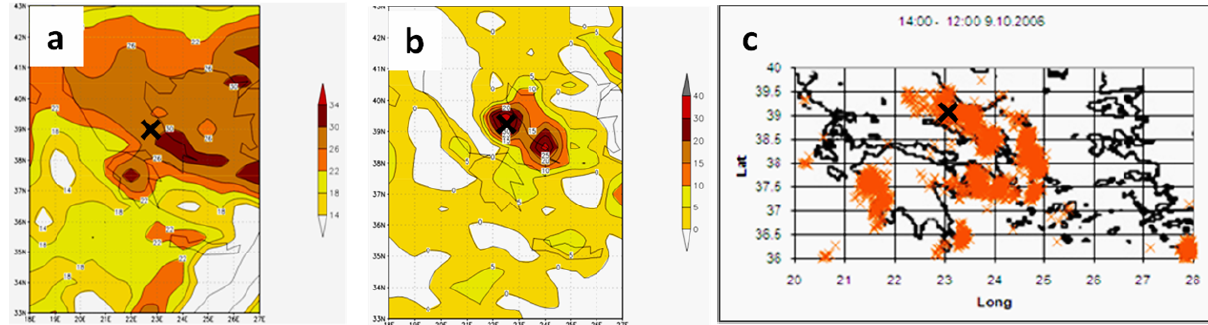
Fig. 7. Spatial distribution of MKI (a) and RDI (b) for 9 October 2006 12:00UTC and integrated lightning activity for 12:00–14:00UTC (c) . The X signs for Volos